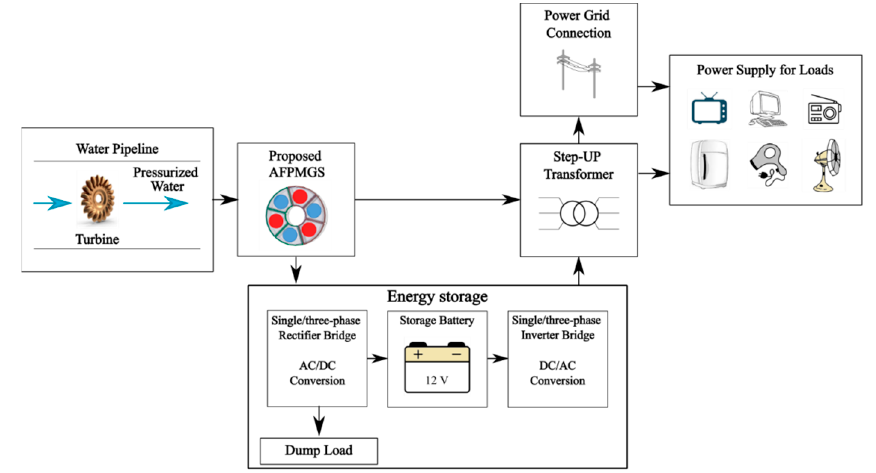
Figure 1. Overview for pico hydropower application.